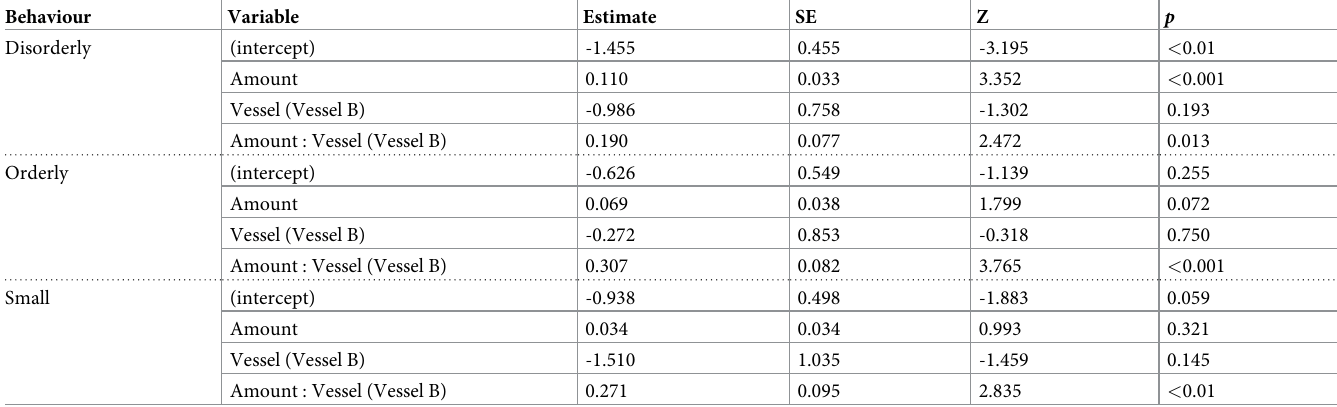
Table 5. Dirichlet regression results of the most parsimonious model. Parameters of the best selected model to explain the behavioural composition (comprised of small, orderly and disorderly behaviours) of fish slipped from purse seines, fitted by Dirichlet regression. Behaviour